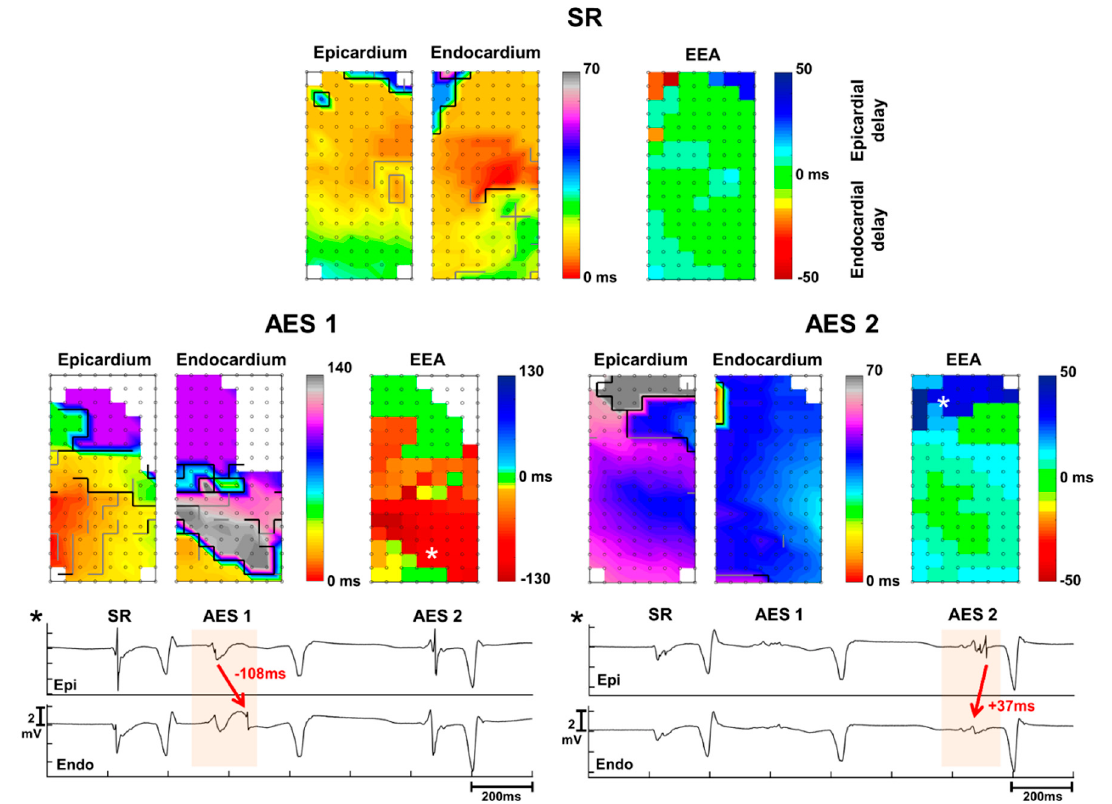
Figure 5. Presentation of severe endocardial delays during atrial extra systoles (AES). Delays reach up to 130 ms at the lower part and the upper part is refractory. However, with the second immediately following AES the delay shifts to the epicardium (epi) with delays up to 50 ms at the upper part. Electrogram examples demonstrate the severe delays at the endocardium (endo) for the first AES and at the epicardium for the second AES. Asterisks refer to the site of the electrograms in the corresponding maps. SR = sinus rhythm.